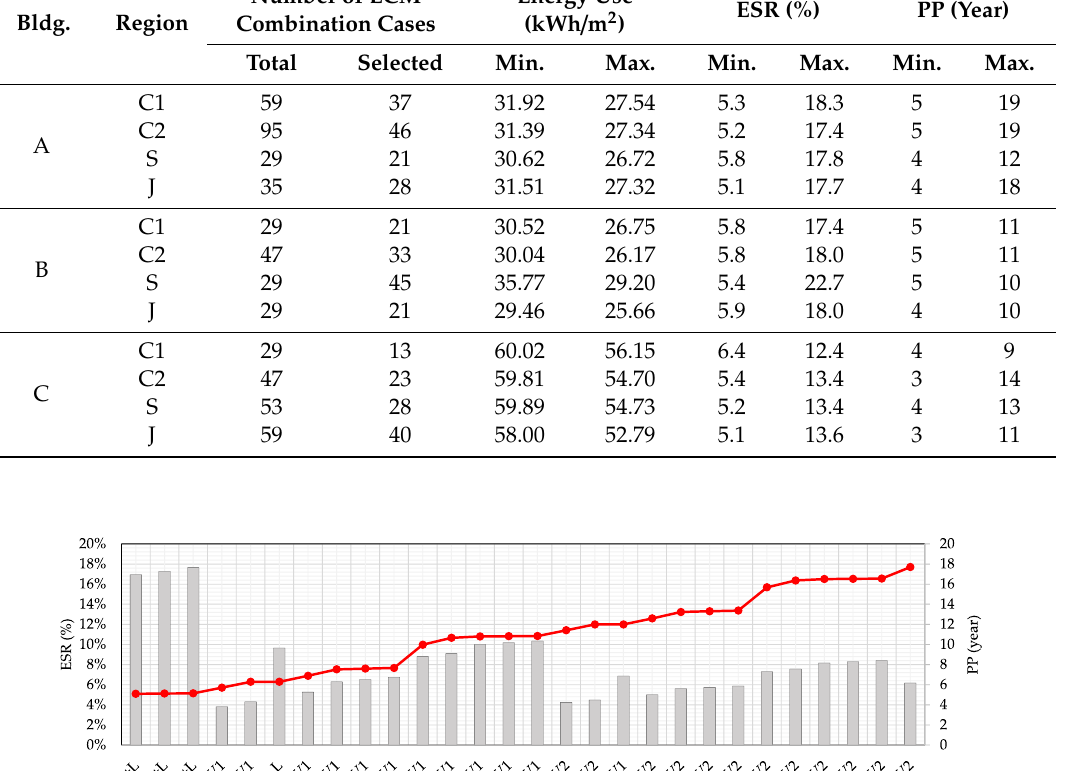
Table 15. Minimum and maximum values of energy use, ESR, and PP according to ECM combinations. Number of ECM Bldg. Region